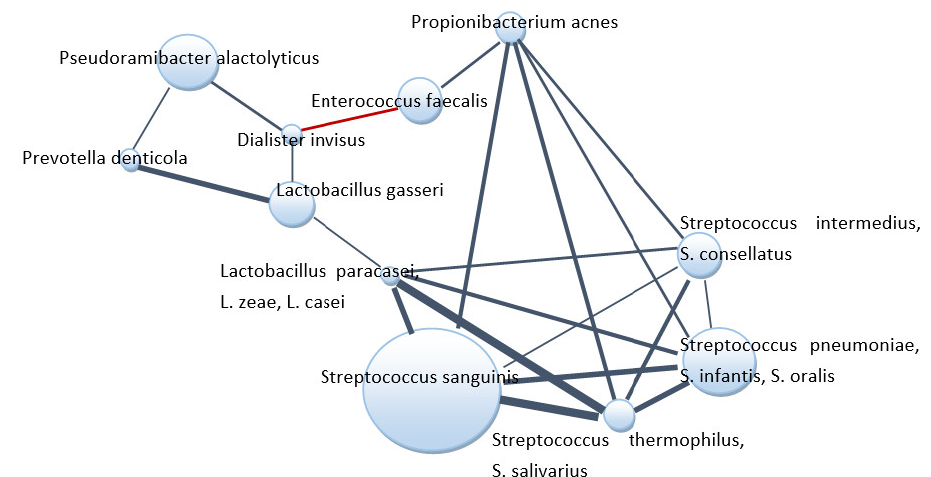
Figure 5. Co-occurrence patterns among most abundant species/genera in root canal samples. The bacteria found in at least eight samples and with a minimal average relative abundance of 1% (considering all root canal samples) were analyzed. The edges represent positive (blue) and negative (red) Spearman correlations ( p < 0.05). The line thickness is proportional to the absolute value of the Spearman correlation. Node sizes reflect average relative abundance of each species’/genera’s genes.